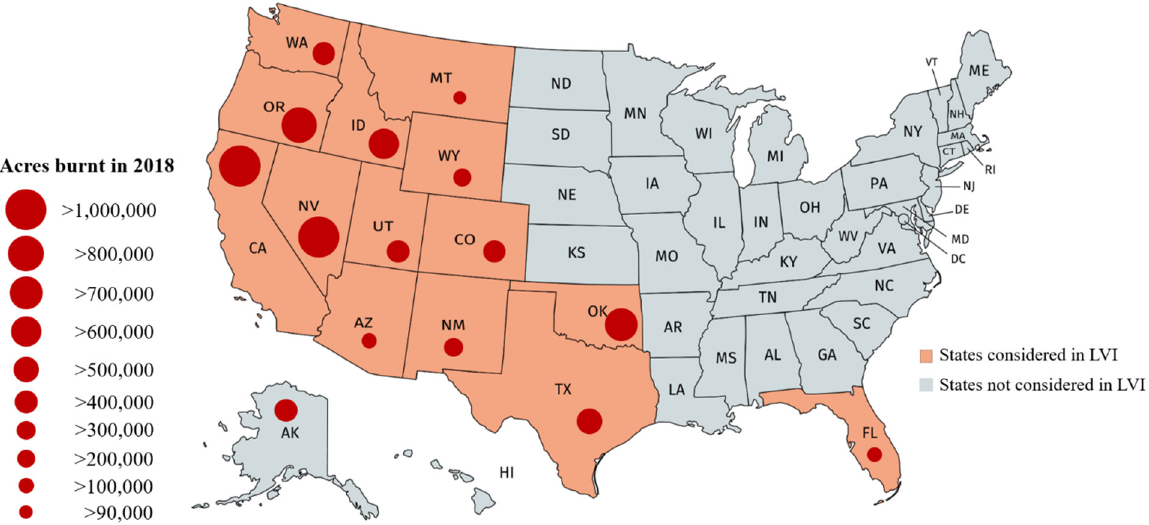
Figure 2. Map of the United States with the states that are analyzed shaded in orange and states not considered shaded in gray. The acreage size burnt in 2018 and 2019 is indicated by the red circles, ranging from the smallest circle (burn area less than 90,000 acres) to the largest circle (burn area exceeding 1 million acres).